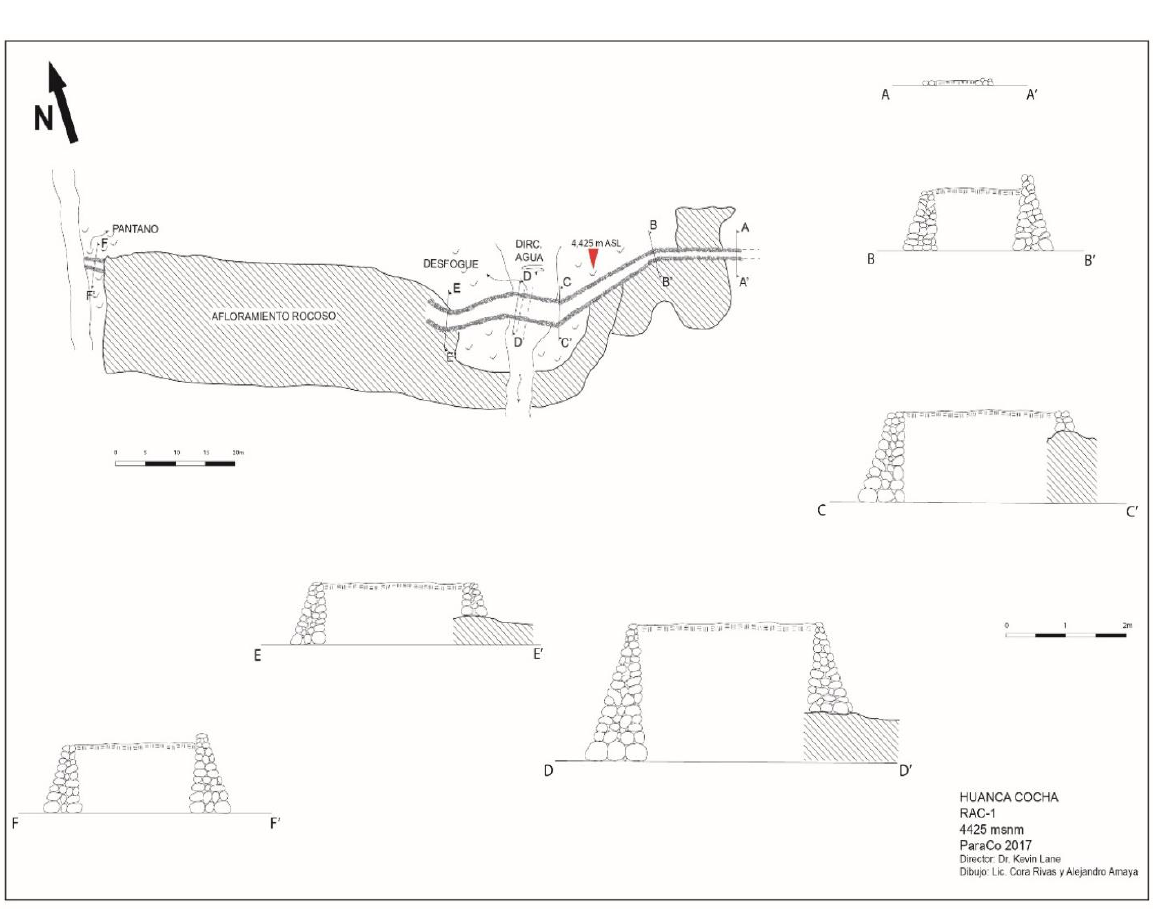
Figure 10. Plan of the Huancacocha silt dam [Rac 1].